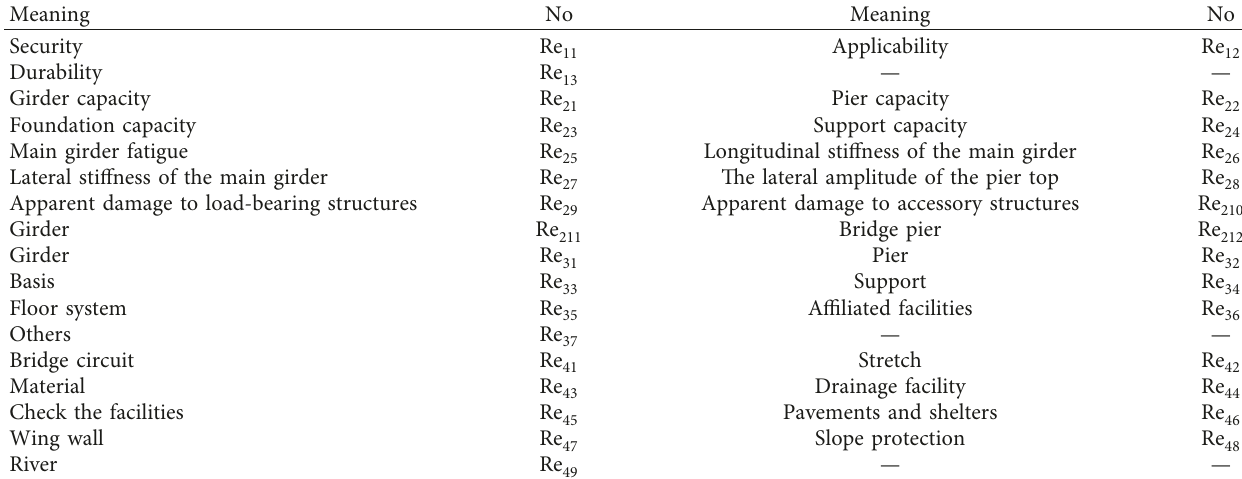
Table 5: Risk factors and numbers of existing railway bridges.